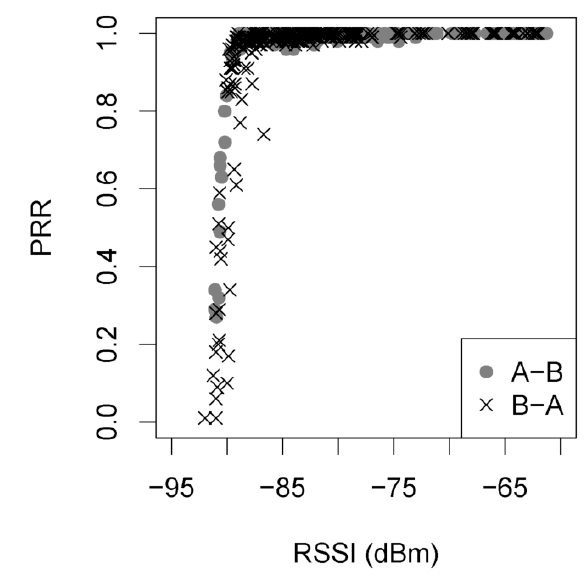
Figure 2. Packets reception rate vs. RSS